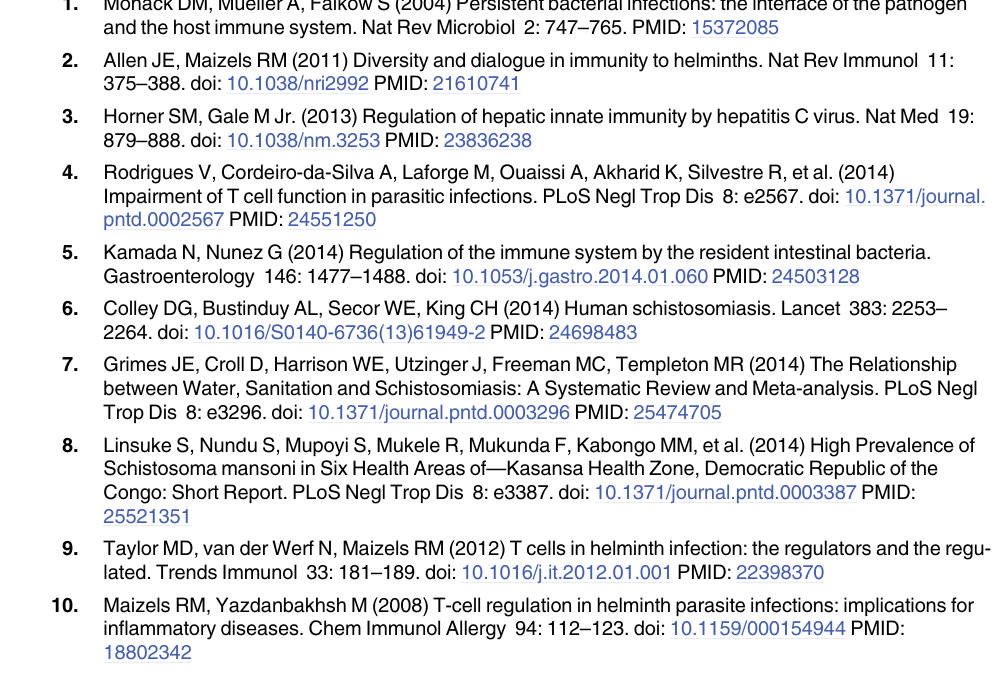
S3 Fig. Levels of serum AST/ALT. S . japonicum -infected mice were immunized with SjHSP60 and/or injected intraperitoneally with anti-CD25 PC61 depletion mAb to in vivo deplete Tregs. Control mice received normal isotype antibody (rat IgG1). Serum samples were collected 10 days after the last injection and levels of serum AST/ALT were determined. Data are means ± SD of 15 mice from three independent experiments. (cid:3) P < 0.05, (cid:3)(cid:3)(cid:3) P < 0.001. (TIF) S4 Fig. Prediction results of 3D structure and protein-protein interaction sites of SjHSP60. Predicted protein-protein interaction sites were mapped onto the surface of the 3D structure of SjHSP60. Amino acids predicted to be interaction sites are shown in red, while non-interacting residues are shown in white. (TIF) S1 Text. Supporting text. This file contains supplementary methods, including expression and purification of SjHSP60, deletion of SJMHE1 from SjHSP60, evaluation of liver injury, and pre- diction of protein structure and protein-protein interaction